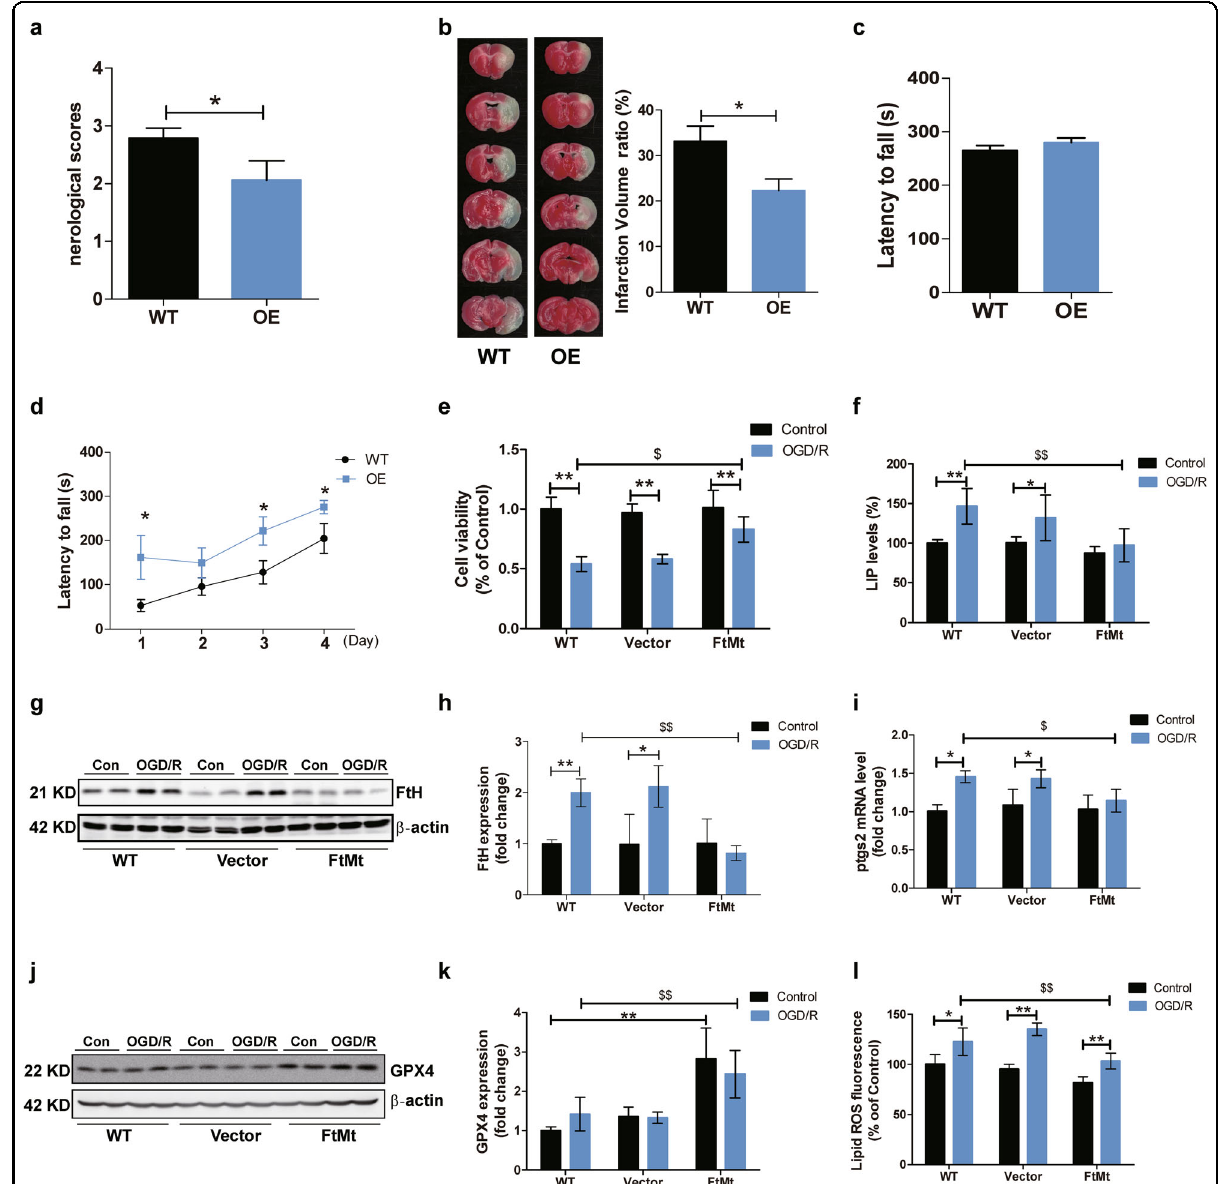
Fig. 7 FtMt overexpression attenuates iron-mediated ferroptosis and brain damage in cerebral I/R. Wild-type and FtMt-overexpressing mice were subjected to I/R surgery. a Neurologic de fi cit scores ( n = 15) and ( b ) infarct volumes ( n = 5) were measured. Motor coordination was measured by the rotarod treadmill test as described in the “ Materials and Methods ” section. c Performance of wild-type and FtMt-overexpressing mice on the last day of training before surgery. d Performance of wild-type and FtMt-overexpressing mice after cerebral I/R ( n = 10). WT, wild-type mice; OE, FtMt- overexpressing mice. Wild-type (WT) SH-SY5Y cells, empty vector transfectants (vector) and FtMt-overexpressing transfectants (FtMt) were subjected to OGD/R treatment. e Cell viability, ( f ) LIP levels, and ( g ) FtH expression were measured after OGD/R. h Quanti fi cation of FtH levels ( n = 4). i Relative mRNA expression of Ptgs2 ( n = 4). The mRNA levels were normalized to β -actin mRNA levels and are expressed relative to the mean value of the WT control (Con) group. j Expression of GPX4 in three types of cells after OGD/R. k Quanti fi cation of GPX4 levels ( n = 5). l L-ROS fl uorescence (C11- BODIPY [581/591] oxidation) was measured in different groups. The results are presented as the mean ± SEM. */$ P < 0.05, **/$$ P <